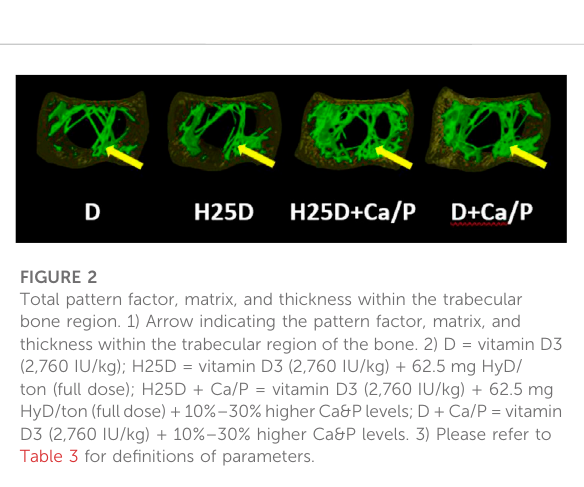
Table 3 for de fi nitions of parameters.